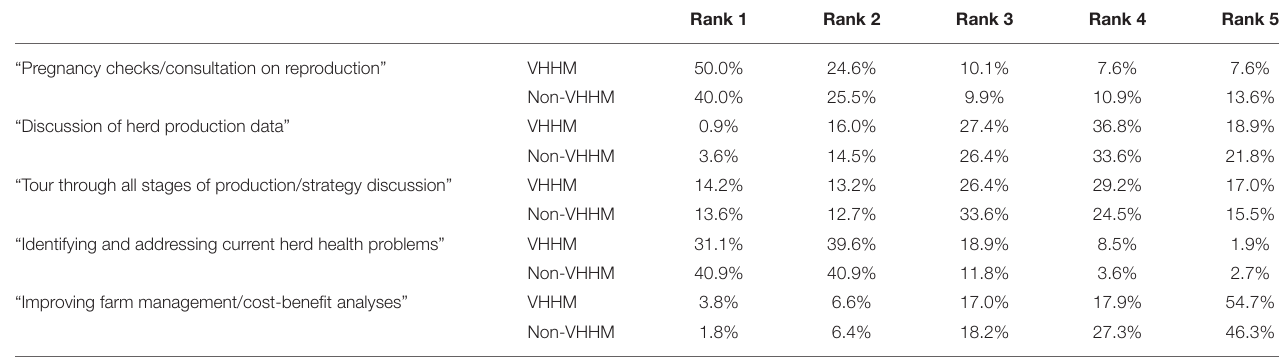
TABLE 5 | VHHM: Motivation of